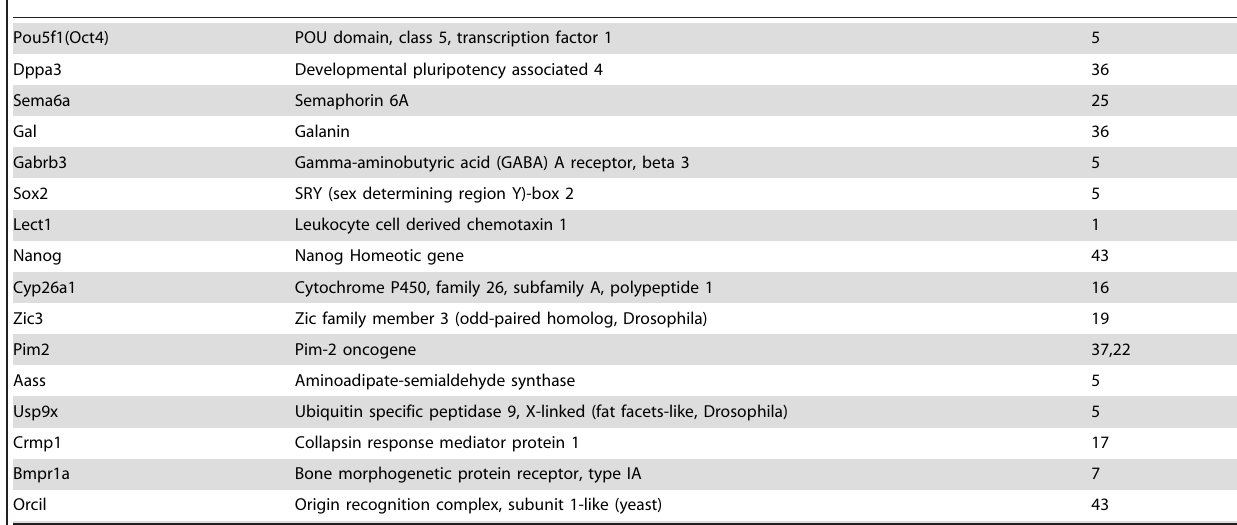
Table 4. Selective Set of Upregulated Genes in Fracture Healing Common to ESC